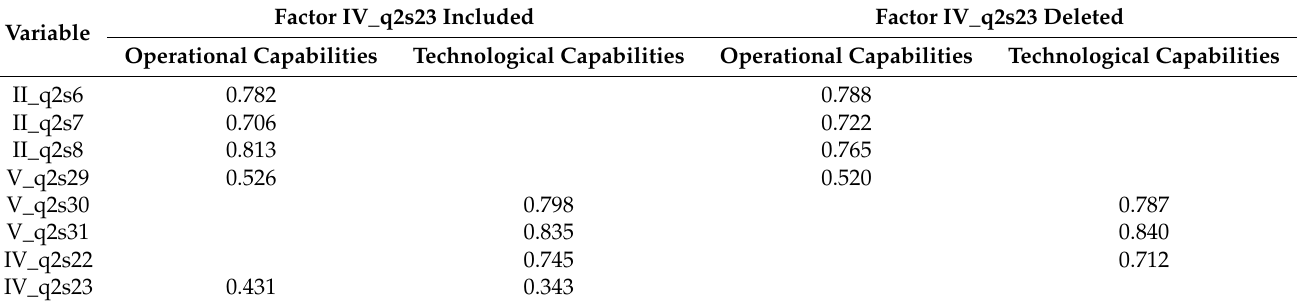
Table 8. Factor loadings for TC and OC.